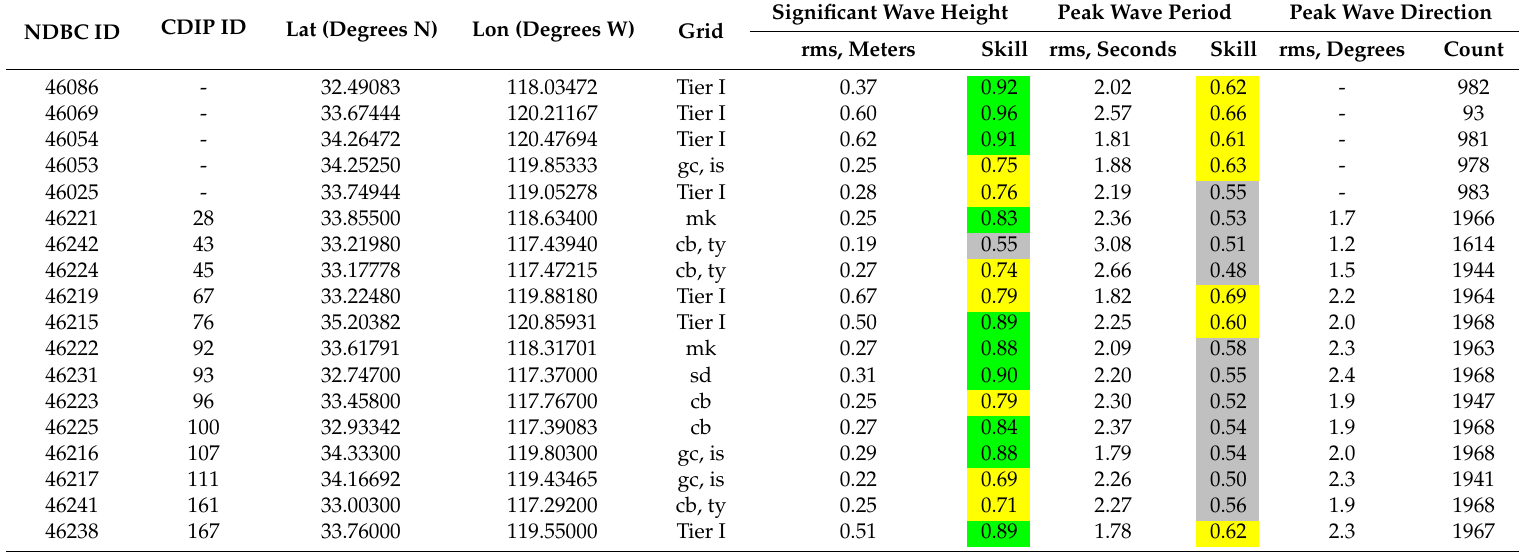
Table B1. Comparison of modeled and measured waves for the January 2010 validation storm. Grid refers to either Tier I or a Tier II grid abbreviation (Figure